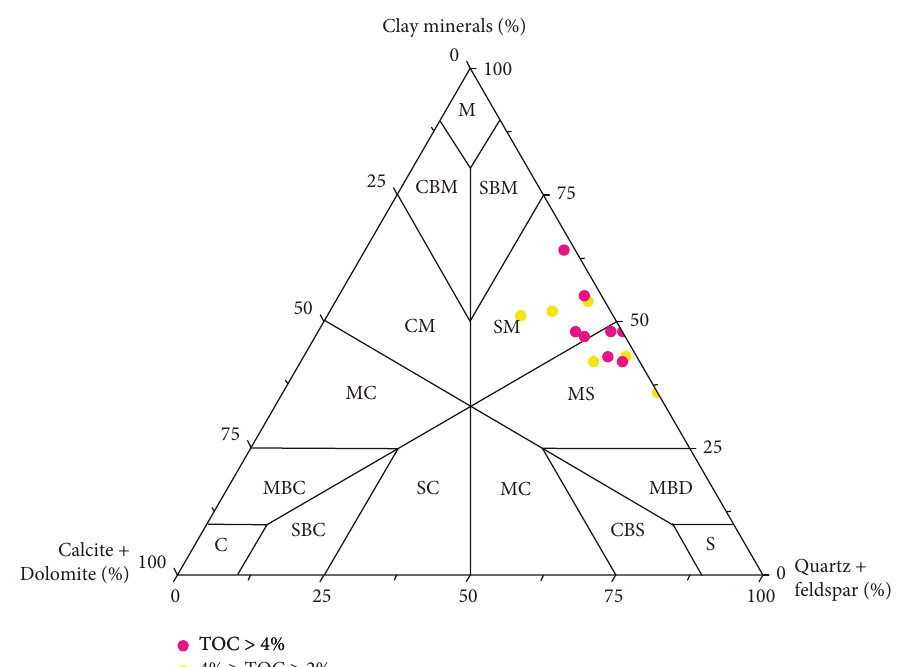
Figure 2: Ternary diagram of lithofacies classi fi cation with mineralogy shale samples investigated from the Chang 7 formation shales in the Erdos area [55]. M: mudstone; S: siltstone; C: carbonatite; SA: siliceous mudstone; CM: calcareous mudstone; MS: muddy siltstone; CS: calcareous siltstone; MC: muddy carbonatite; SC: siliceous carbonatite; SBM: siliceous-bearing mudstone; CBM: calcareous-bearing mudstone; MBS: mud-bearing siltstone; CBS: calcareous-bearing siltstone; MBC: mud-bearing carbonatite; SBC: siliceous-bearing carbonatite.